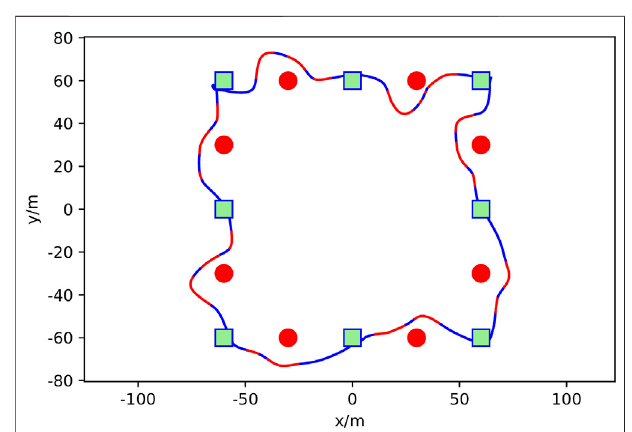
FIGURE 8 | Simulated ASV obstacle avoidance mission showing mission waypoints asgreen squares, obstacles in red, DRL agent augmented pathsforavoidanceinred,andthevehicletrajectoryfollowingthemissionpath in blue. The trajectory runs counter-clockwise from the top center mission